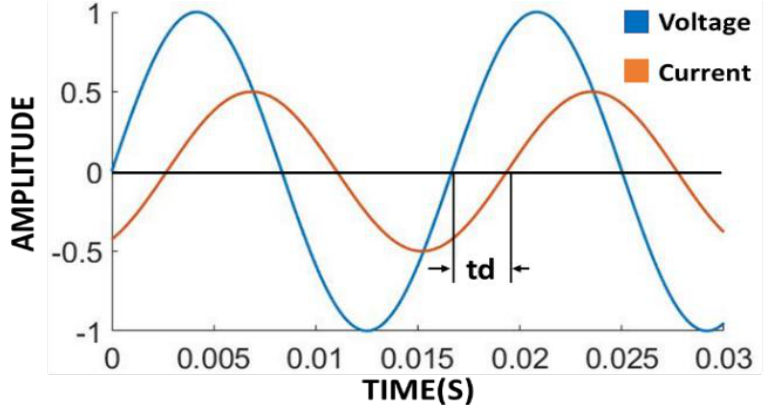
Figure 3. Signal offset between AC voltage and